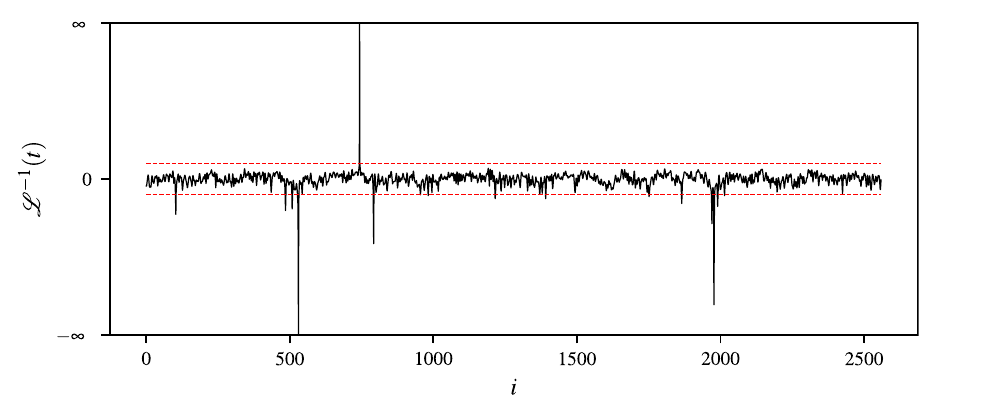
Figure 3. Plot of inverse Lehmer transform against